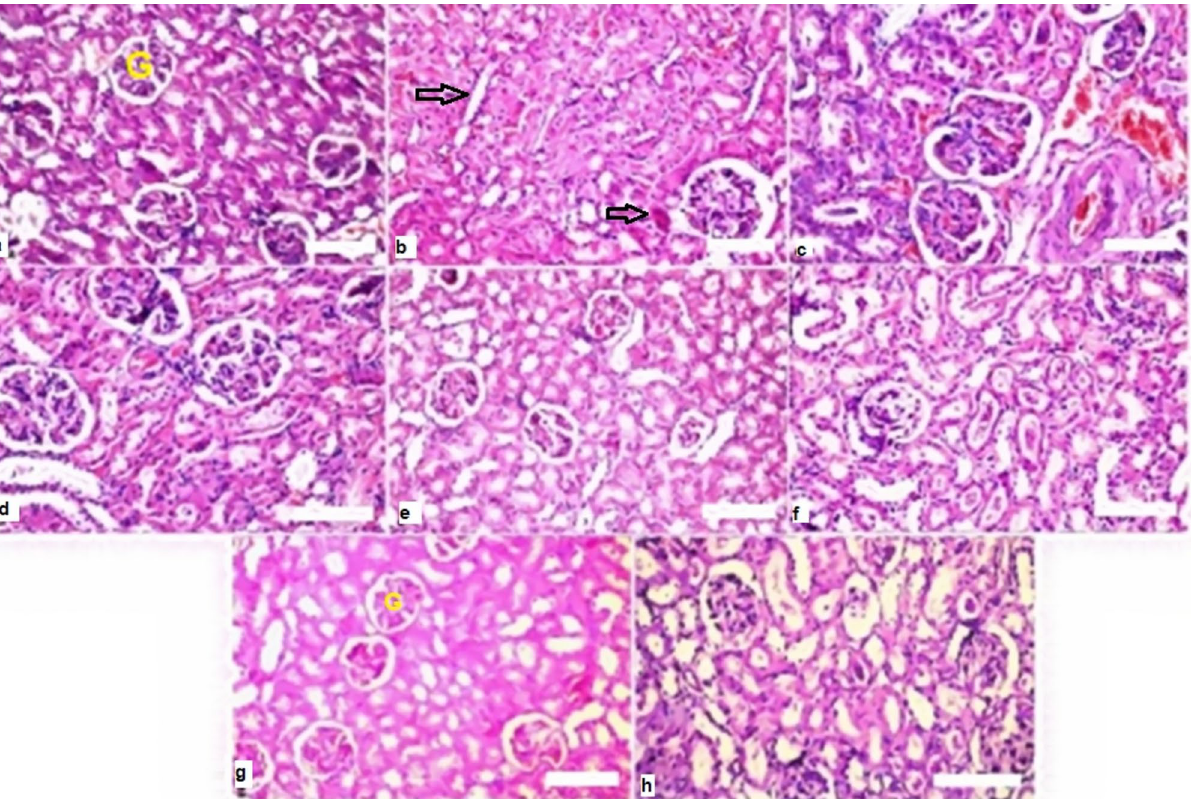
Figure 7. Histopathological findings in kidney (a) normal glomeruli (G) and tubules at the cortex in kidney. (b) Focal inflammatory cells infiltration with fibrosis in between the glomeruli and tubules at the cortex in kidney (arrows) of exposed rats. (c,d) Irradiated rats were administered of BV 0.05 or propolis 300 mg/kg respectively showed no alteration (score 0) of kidney. (e) Effect of combination treatment of propolis + BV 300 & 0.05 mg/kg respectively showed normal histological structure (score 0) in kidney. (f–h) Effect of propolis 300 mg/kg and BV 0.05 separately and combined (respectively) on the normal rats for two weeks without any alterations in kidney. H&E stain